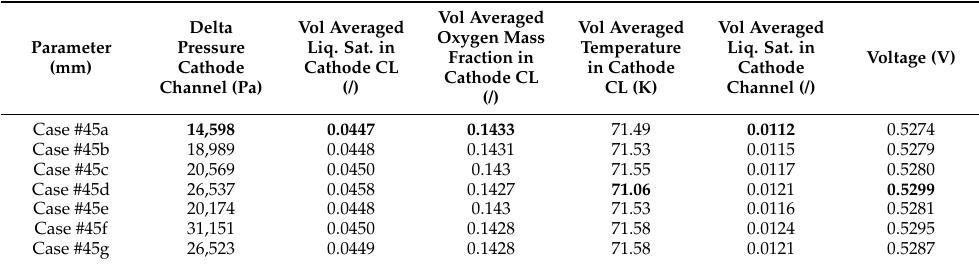
Table 9. Comparison of parameters of interest for cases using scaling factors (#45b-g) vs.